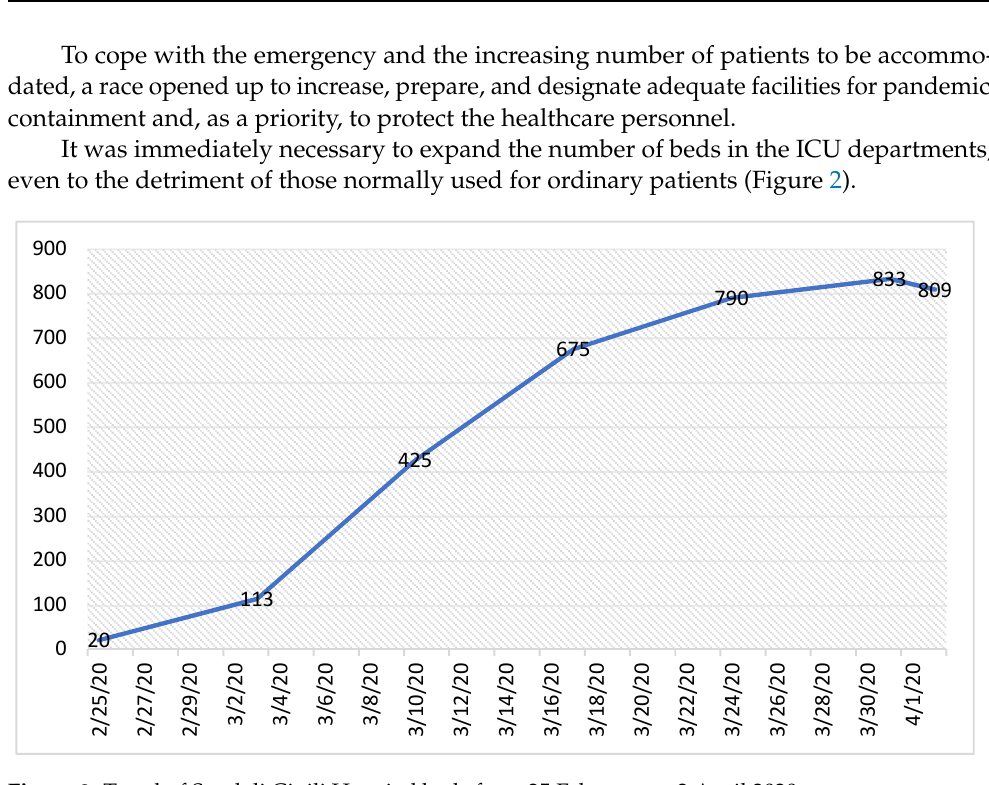
Figure 2. Trend of Spedali Civili Hospital beds from 25 February to 2 April 2020 .